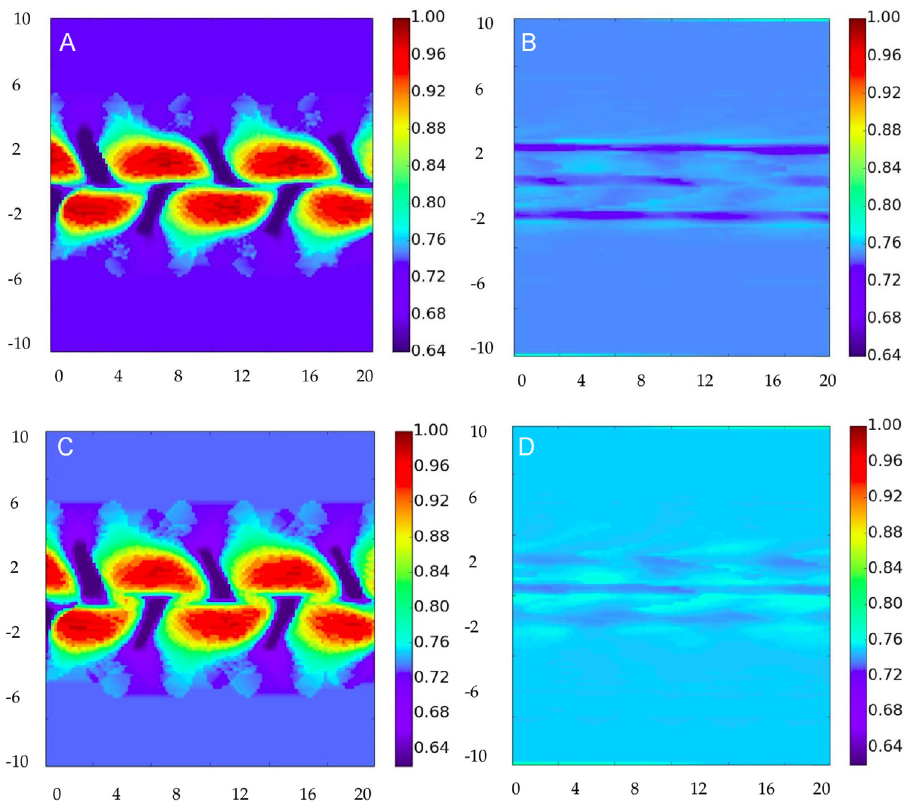
Fig 3. Node clustering coefficient for the correlation networks constructed for different flows and decay rates. Panels are for the same parameters as in Fig 2.